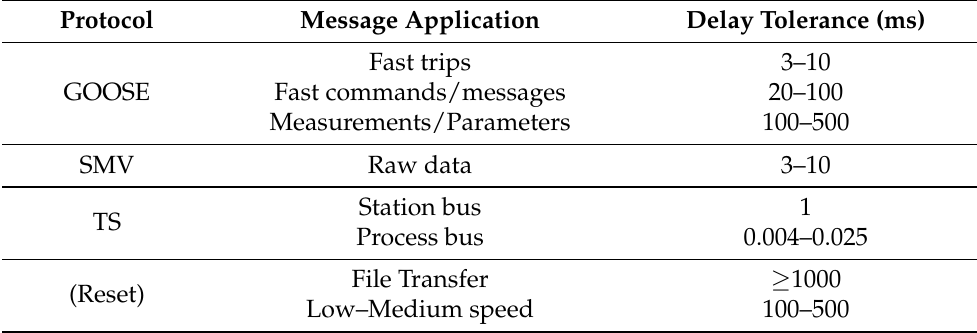
Table 5. Communication timing for wide area power network under IEC 61850 standard.